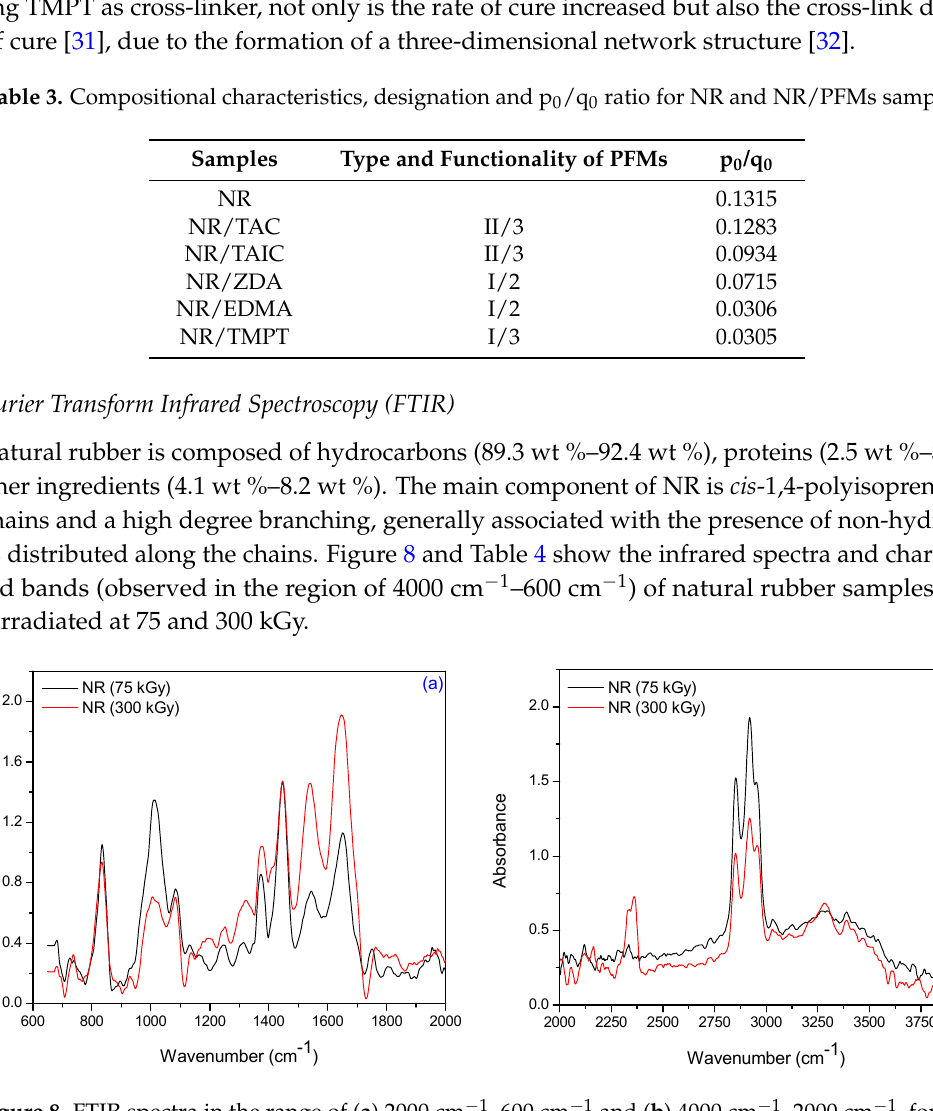
Figure 8. FTIR spectra in the range of ( a ) 2000 cm − 1 –600 cm − 1 and ( b ) 4000 cm − 1 –2000 cm − 1 , for NR irradiated at 75 kGy and 300 kGy. Table 4. The mass losses of samples immersed in Water, Sodium hydroxide (1%), Ethylic alcohol (96%), Acetic acid (10%), Sodium chloride (0.9%) and Glucose monohydrate (10%).